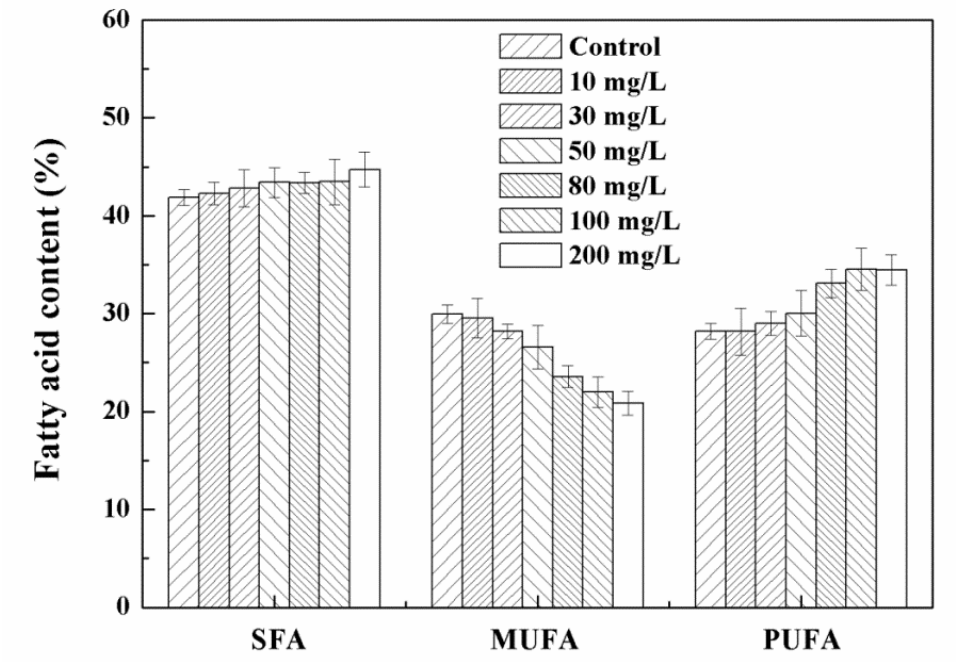
Figure 3. Fatty acid contents and components of Chlorella sp. UJ-3 exposed to different concentrations of Fe 3 O 4 NPs (Culture time: 21